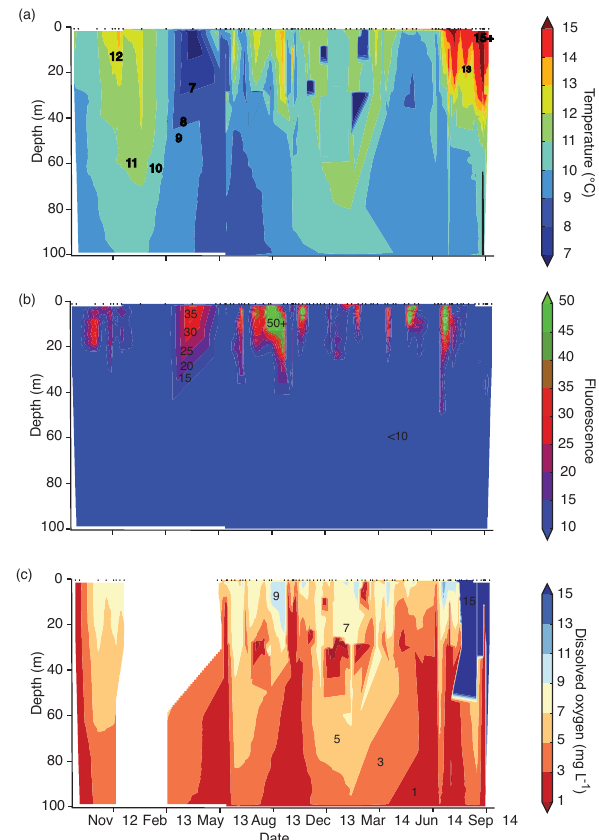
Figure 2. A time series of CTD cast profiles for (a) temperature, (b) productivity, and (c) DO taken between September 2012 and October 2014. Time series are compiled from CTD casts at BL5 in conjunction with plankton tows and supplemented with data from weekly CTD casts taken at BL1 as a part of the Bodega Ocean Ob- serving Node. Black points at the top of each figure denote the lo- cation of each CTD